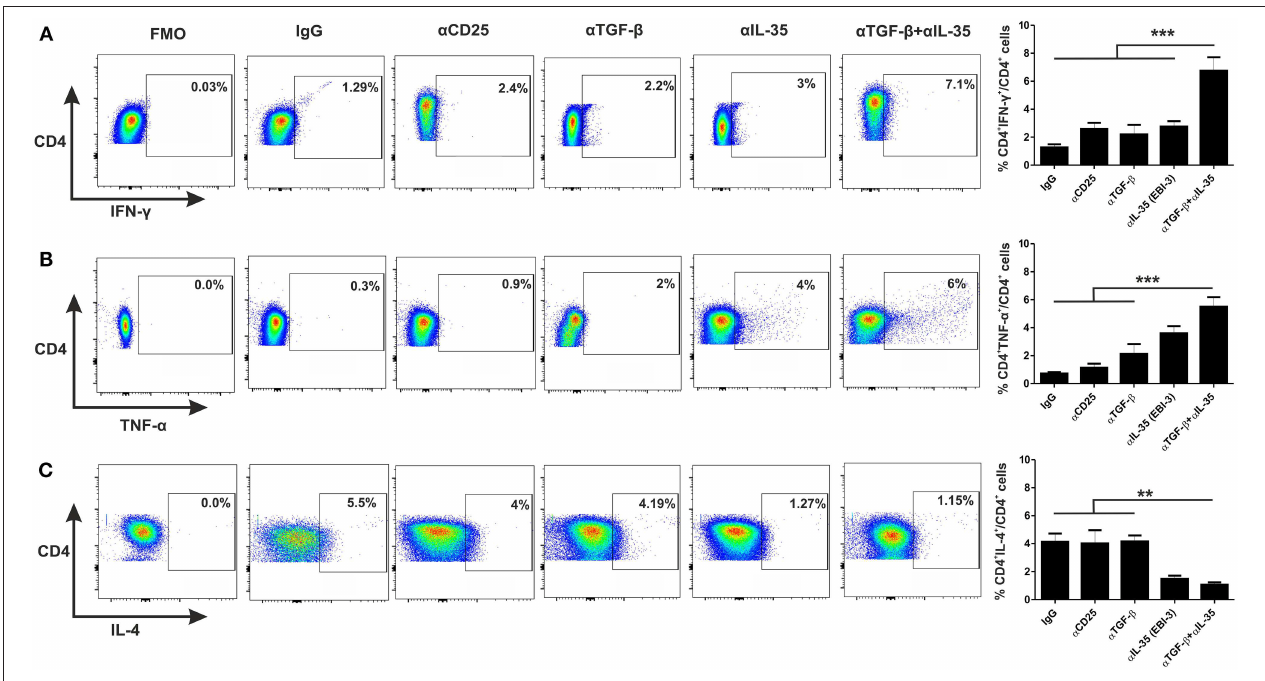
FIGURE 5 | Administration of neutralizing antibodies promotes proinflammatory cytokine producing CD4 + T cells. Infected mice treated with various neutralizing mAbs were sacrificed and their splenocytes were stimulated with LAg (10 µ g/ml) and cultured. After 24h, cells were processed for FACS studies as described in Materials and Methods. Percent population CD4 + T cells producing IFN- γ (A) , TNF- α (B) , and IL-4 (C) were studied post acquisition of the data. Data expressed as means ± SE for five mice per group are representative of two independent experiments with similar results. ** P < 0.01; *** P < 0.001 as assessed by one-way ANOVA and Tukey’s multiple comparison